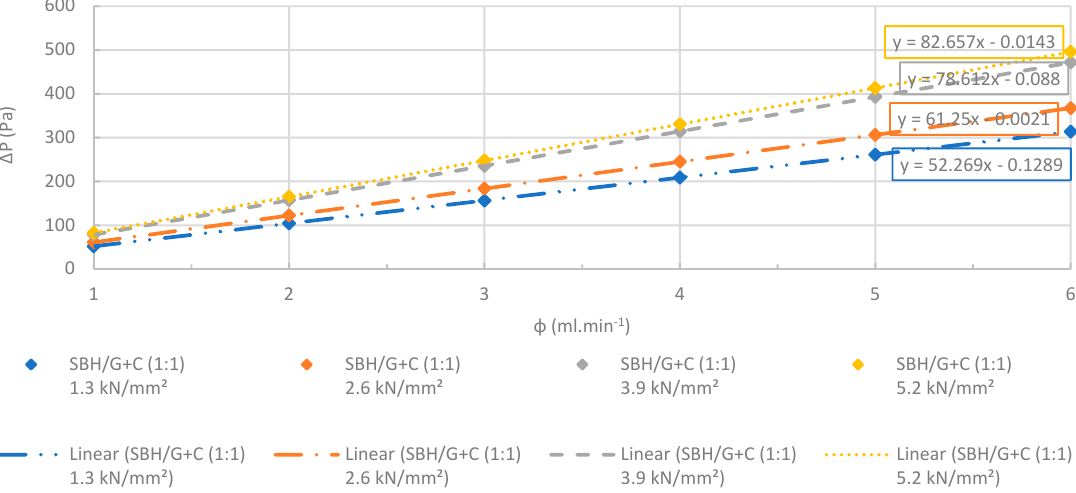
Figure 24. Changes at di ff erential pressures of the SBH / G + C (1:1) pellets with increasing flow rates. R 2 > 0.99. The accuracy of the pressure measurements was less than 0.1%.